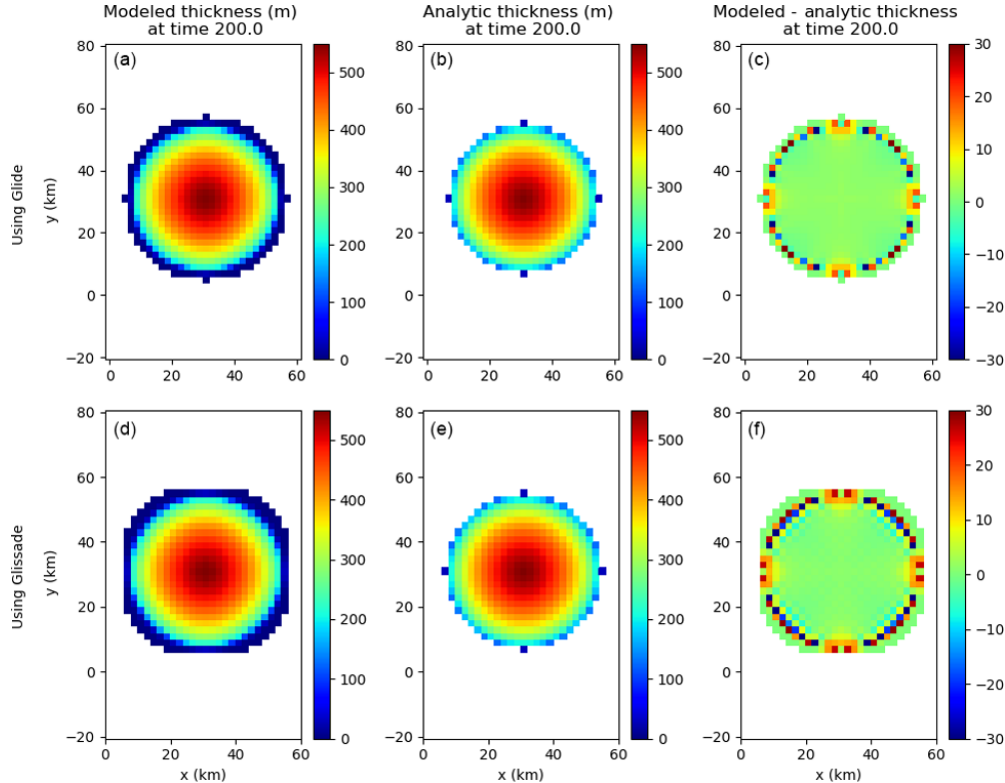
Figure 1. Results from the Halfar dome test using SIA solvers from Glide (a, b, c) and Glissade (d, e, f) . (a, d) Modeled ice thickness. (b, e) Analytic ice thickness. (c, f) Difference between modeled and analytic